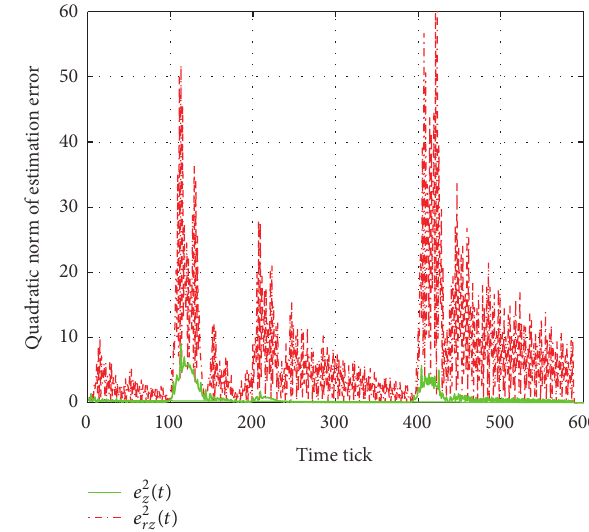
Figure 8: Quadratic norm of estimation errors for ZOH policy.